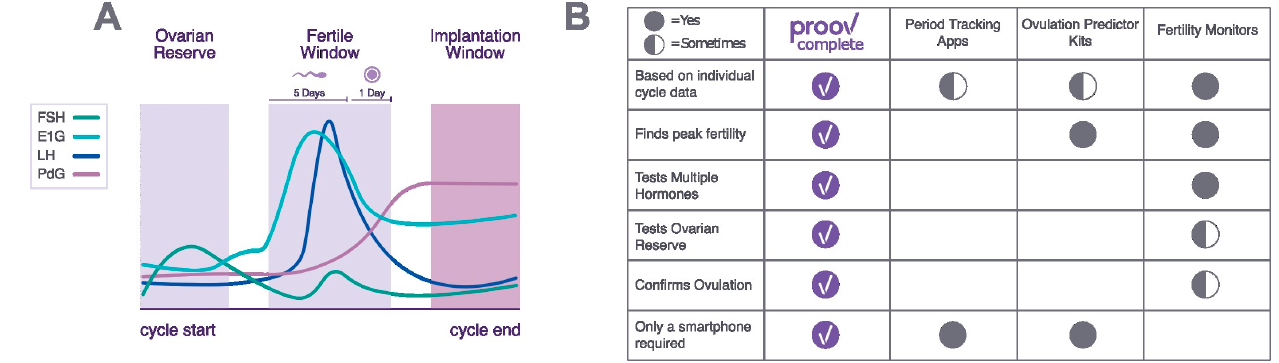
Figure 1. The need for a comprehensive at-home test kit to detect the entire fertile window. ( A ) Proov Complete will test FSH, E1G, LH, and PdG to find the entire fertile window (the combined time of sperm and egg survival) based on urinary hormone levels. The implantation window is also included in testing. ( B ) Period tracking apps, ovulation predictor kits, and fertility monitors are all common ways of timing intercourse for conception, but all fall short of satisfying consumer needs.